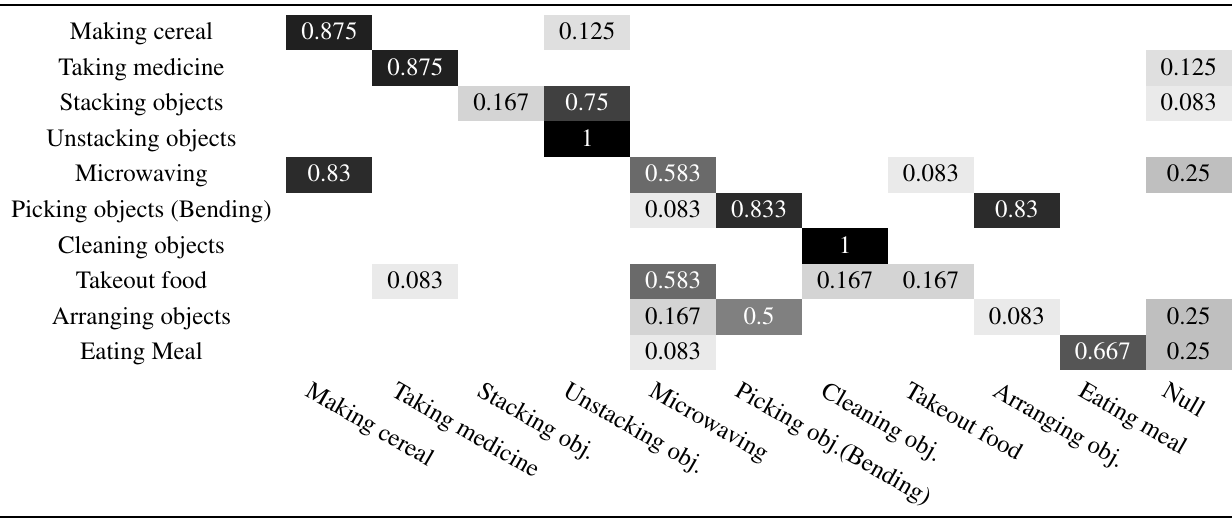
Table 15. Confusion matrix for high-level activities using a naive approach: without applying heuristic filters for the CAD-120